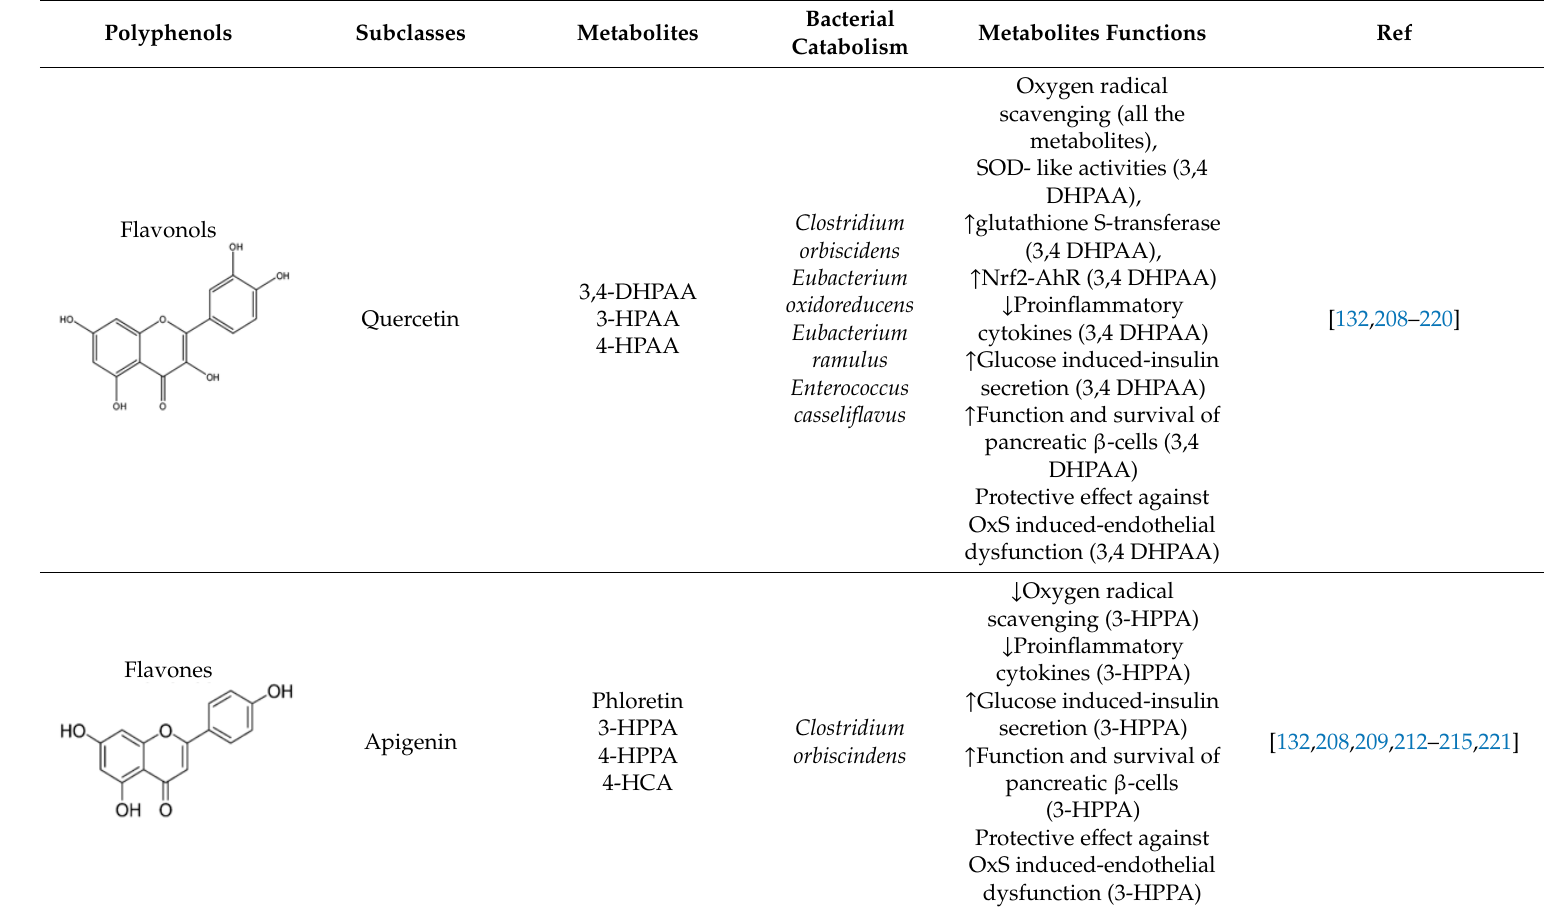
Table 5. Polyphenol metabolites and